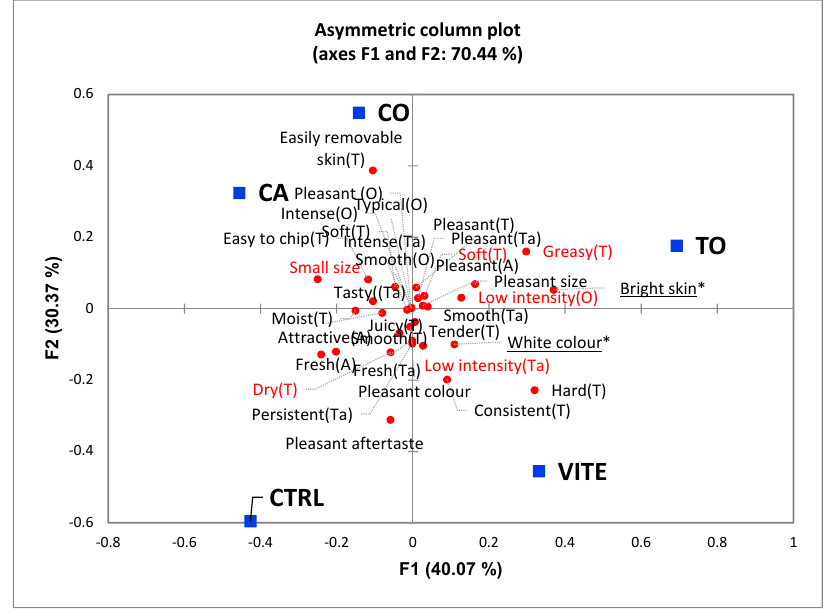
Figure 2. Correspondence analysis applied to open comments data regarding the evaluation of European sea bass fillet by consumers (n = 60). Samples from the same part of the fish muscle (5) were presented, each corresponding to a different dietary treatment. Attributes in red were mentioned as negative aspects; attributes in black were mentioned as positive aspects. (*) underlined attributes with a significant difference between samples, at a significance level of 5%.